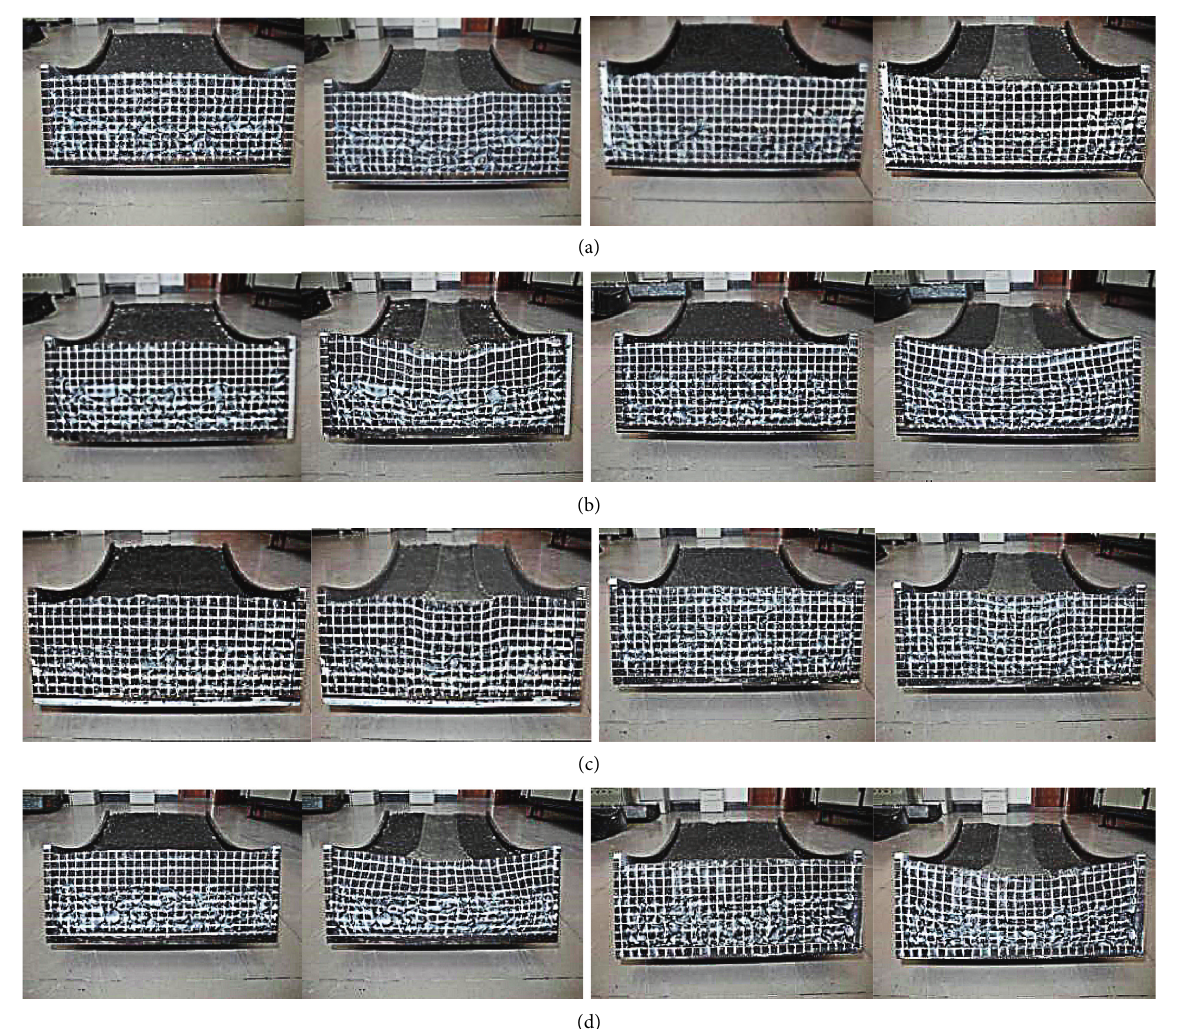
Figure 11: Comparison of the specimens before and after loading. (a) AC13-MOH. (b) MOH-AC20. (c) MOH-MOH. (d) AC13-AC20.